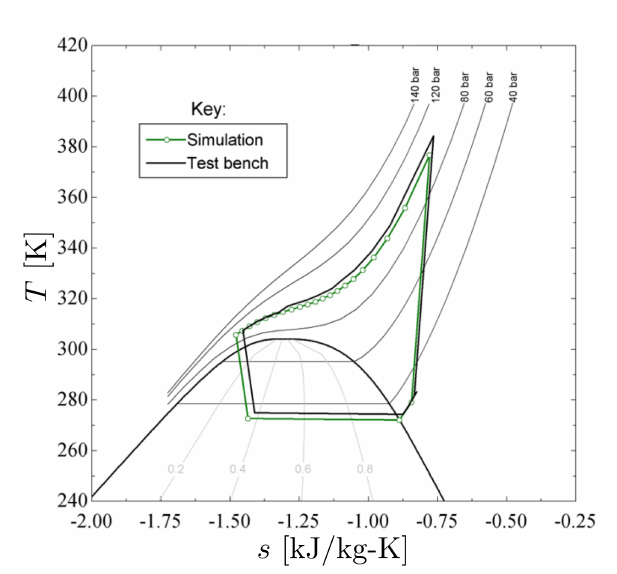
Figure 4. T - s diagram with overlaid experimental and simulated refrigerant cycle (30% EV orifice opening).